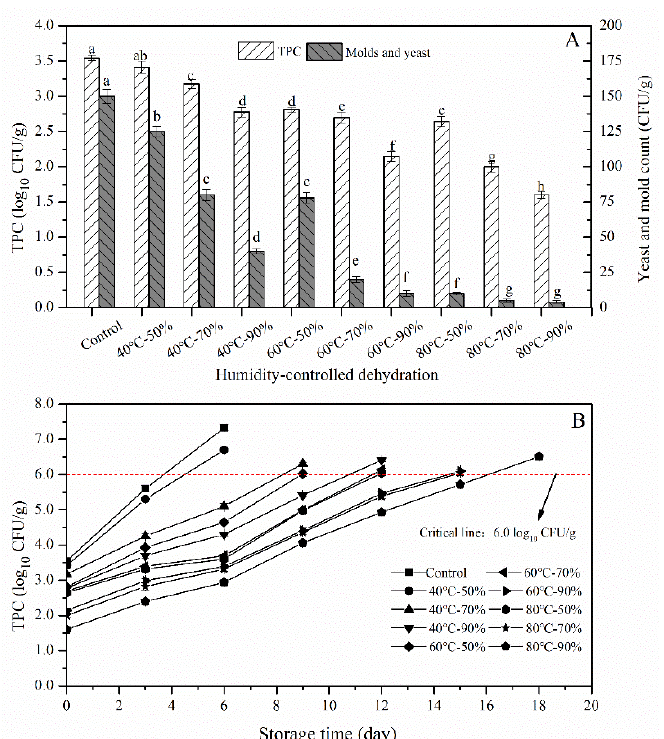
Figure 1. Application of humidity-controlled dehydration (HCD) in microbial control of fresh noodles. ( A ), effect of HCD on the initial total plate count (TPC) and yeast and mold count (YMC). ( B ), effect of HCD on the microorganism growth of fresh noodles during storage. Control, fresh wet noodles; 40 ◦ C-50%, fresh wet noodle samples treated by humidity-controlled dehydration under the condition of 40 ◦ C and relative humidity (RH) of 50%, etc. The different lowercase letter means there was a significant difference in TPC/YMC ( p < 0.05).